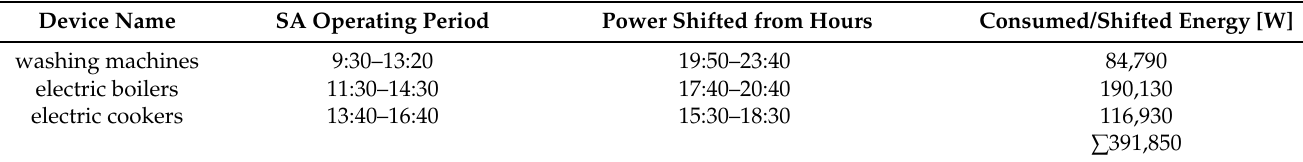
Table 3. Selected SA operating times and energy.